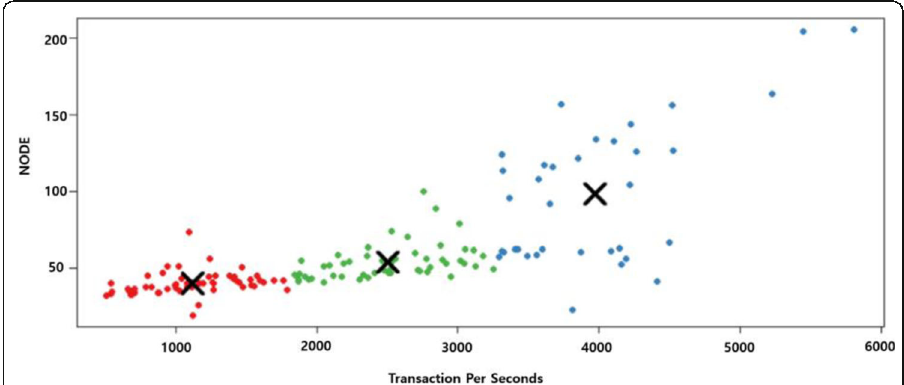
Fig. 16 K-means clustering by using Shiny Package for